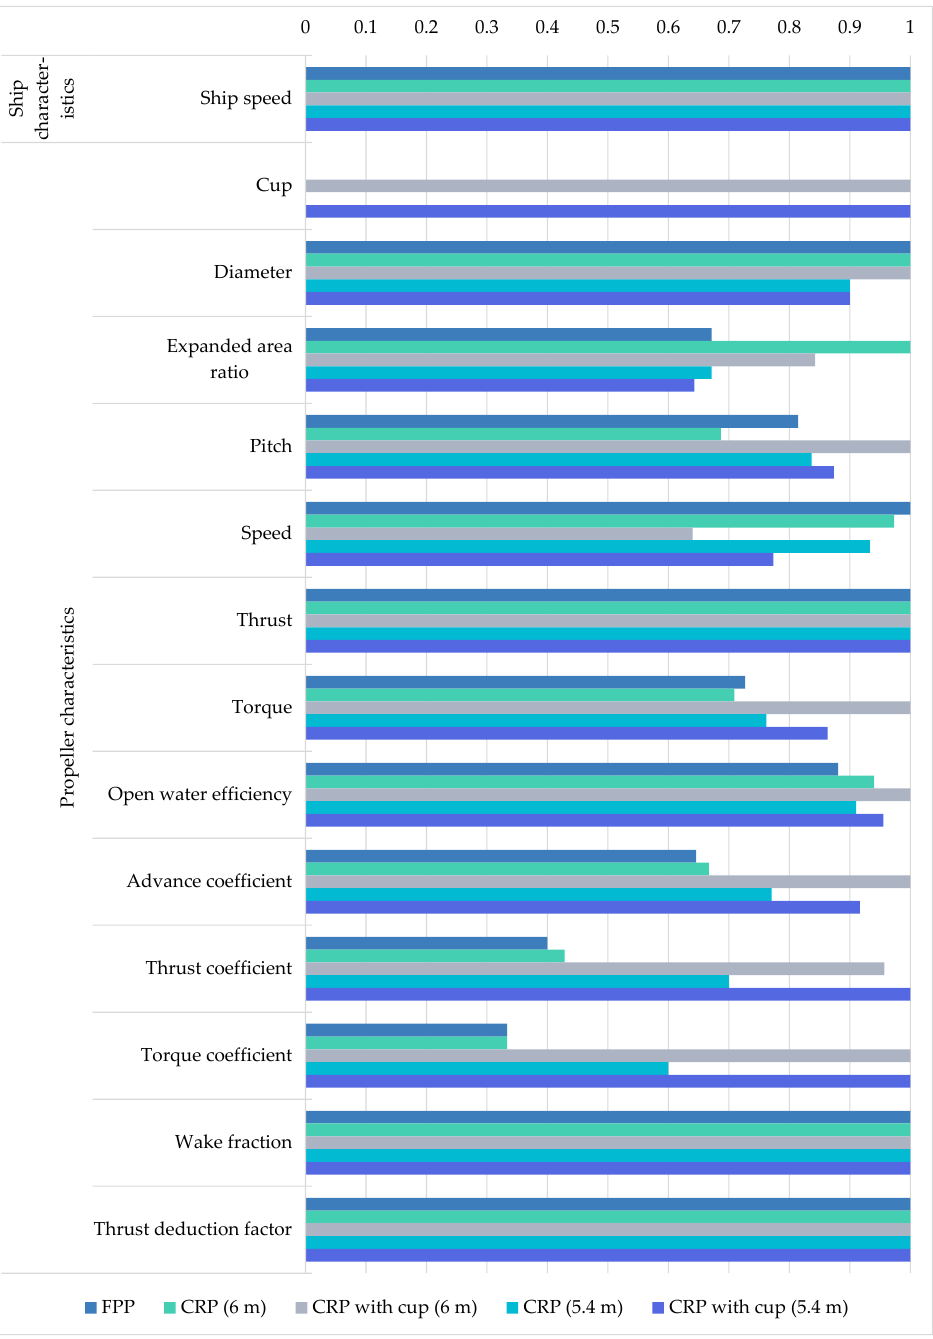
Figure 5. Normalized propeller characteristics for different configurations.